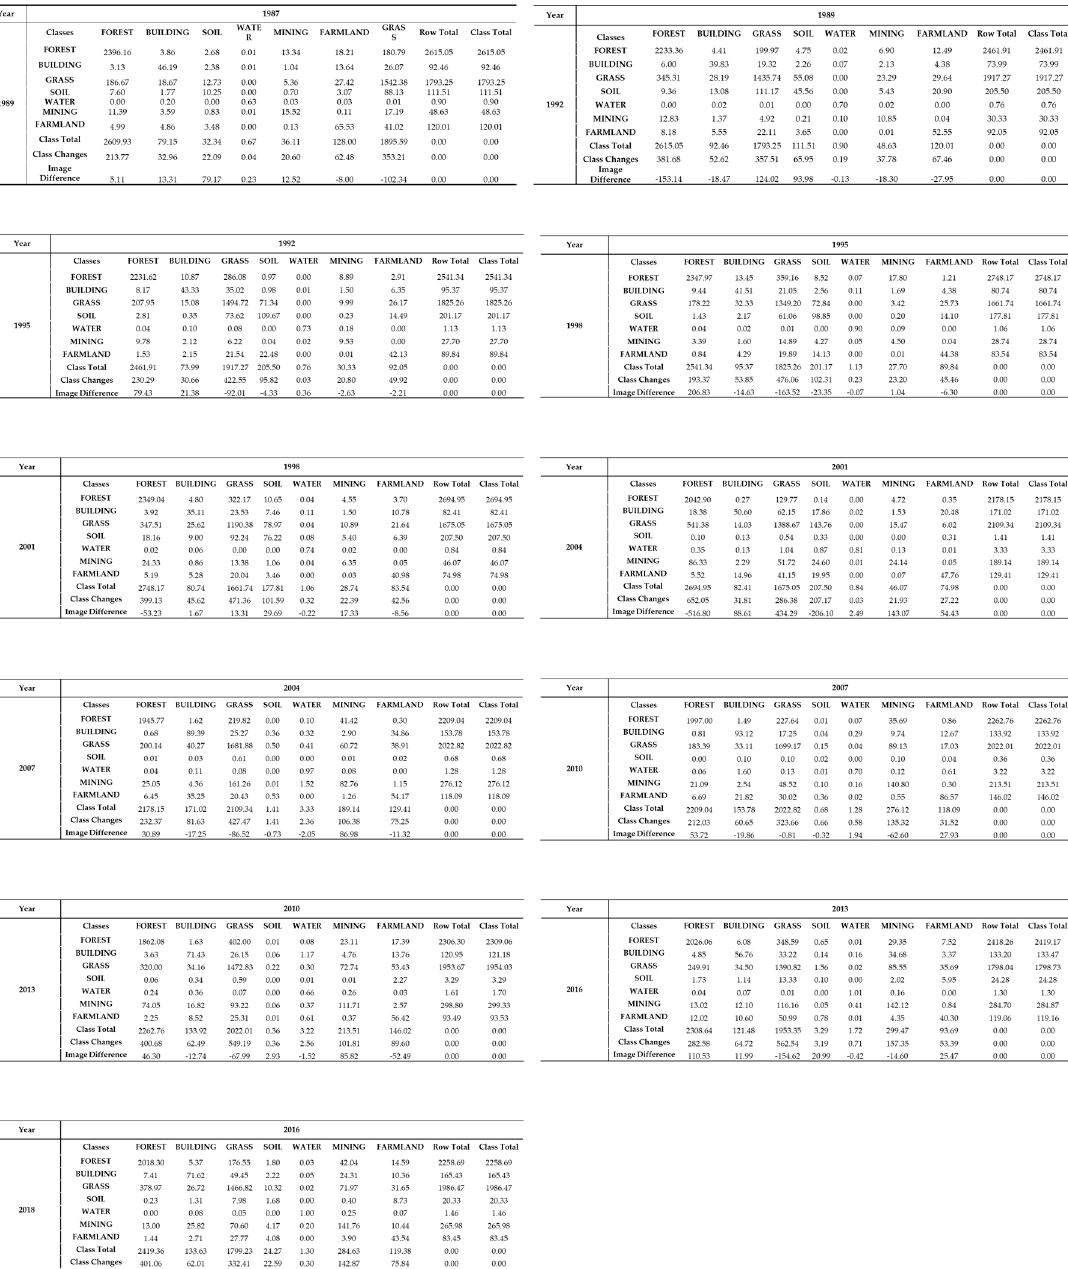
Table 6. The from-to table from 1987 to 2018 for each selected year.